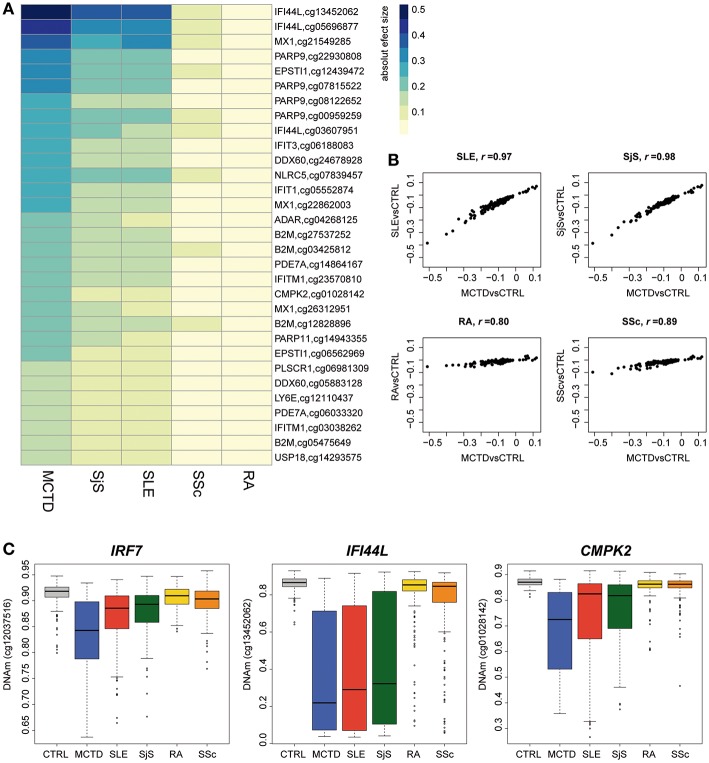
Epigenetic patterns of MCTD-epigenetic signatures in other related systemic autoimmune diseases. (A) Heatmap representing the absolute effect magnitude of epigenetic associations for different systemic autoimmune diseases at those MCTD-DMS showing absolute effect sizes higher than 0.15. Each column represents one disease, each row represents the absolute effect size obtained for the corresponding disease when compared with healthy subjects. (B) Correlation plots comparing the effect sizes obtained in the MCTD epigenetic association results (in the y-axis) with those obtained for other systemic autoimmune diseases (x-axis). (C) Boxplots representing the top differentially methylated CpG-sites between MCTD cases and other SADs. DNAm levels are illustrated in controls, MCTD, SLE, SjS, RA, and SSc.